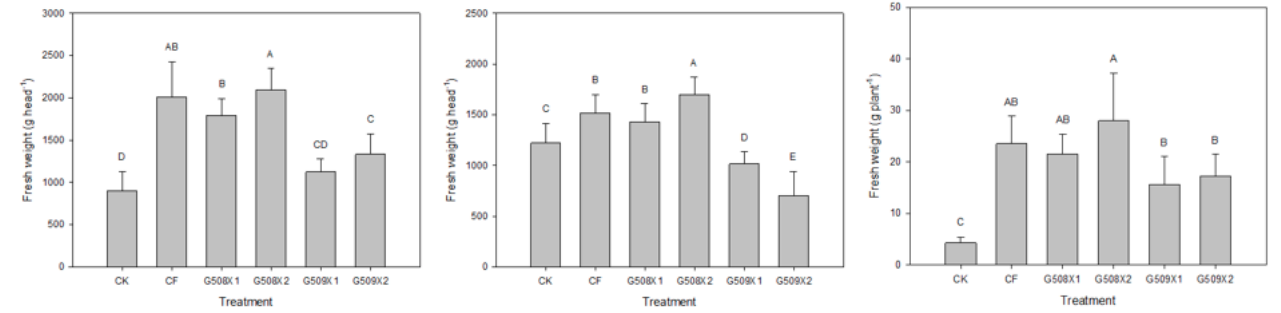
Figure 7. The yields of the three crops under different treatments: cabbage ( left ), Chinese cabbage ( middle ), and water spinach ( right ). The different letters indicate the significance among the treat- ments obtained through one-way ANOVA analysis (Duncan test, p < 0.05, n = 4). The codes have the same meanings as those in Figure 1.